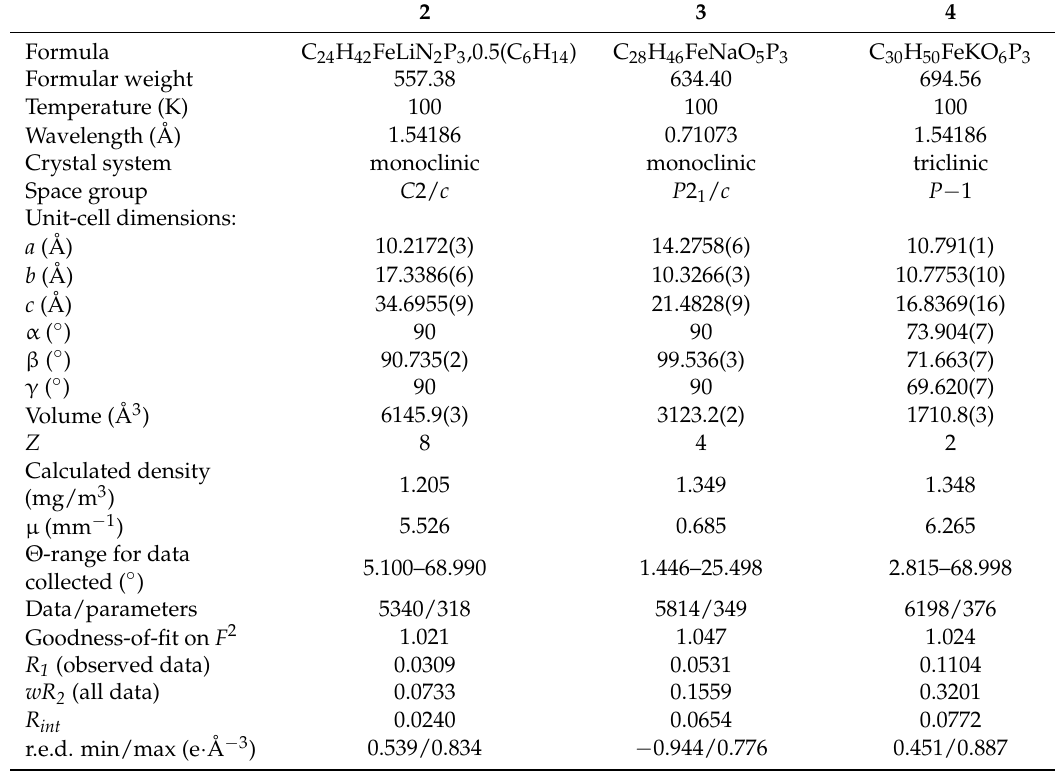
Table 1. Crystal data and structure refinement for Compounds 2 – 4 (Schemes